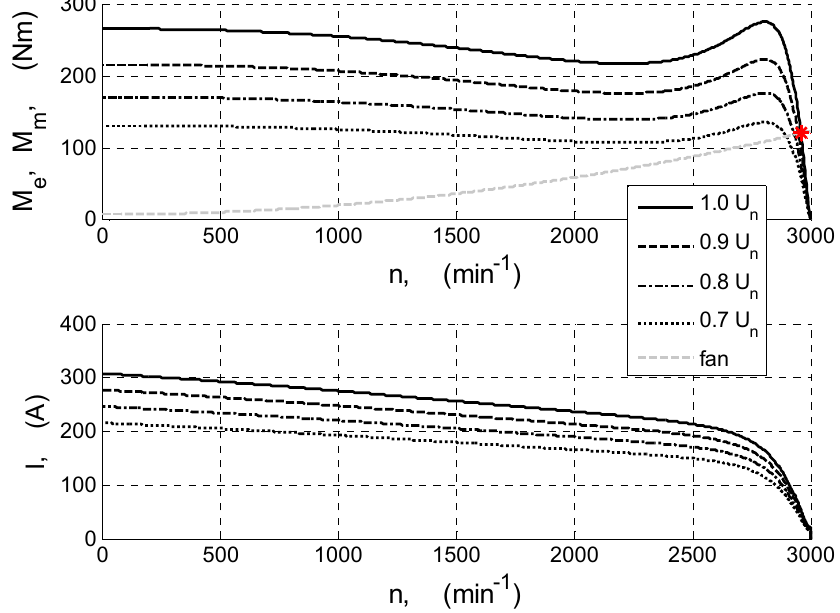
Figure 3. Relation of electromagnetic torque and stator current of the dSOKg 200L2B-E motor as a function of speed for four voltage levels at the motor terminals.